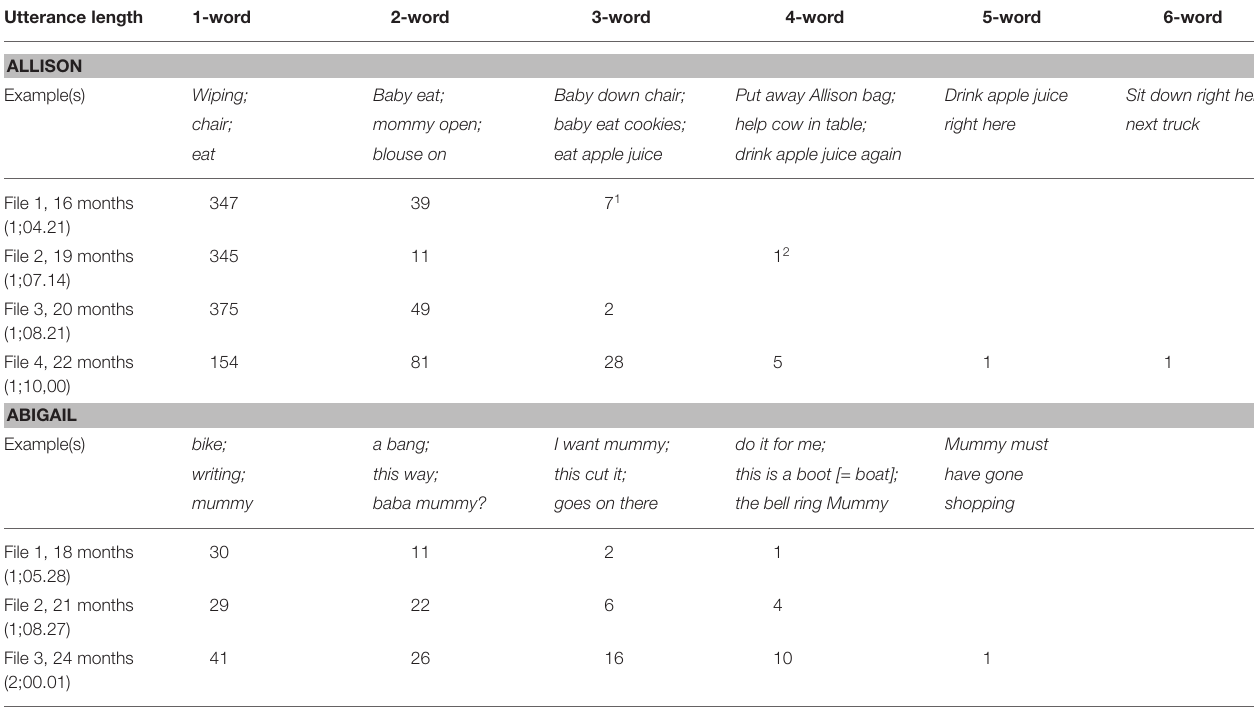
TABLE 2 | Analysis of the speech from Allison (MacWhinney, 2000; Bloom 1973 corpora files 1–4) and Abigail (MacWhinney, 2000, Wells corpora files 1, 2, and 3). Utterance